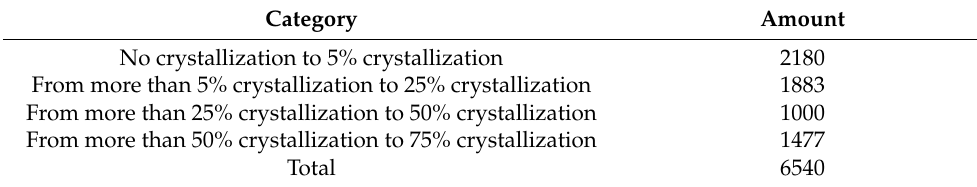
Table 1. Calcium oxalate crystals dataset.